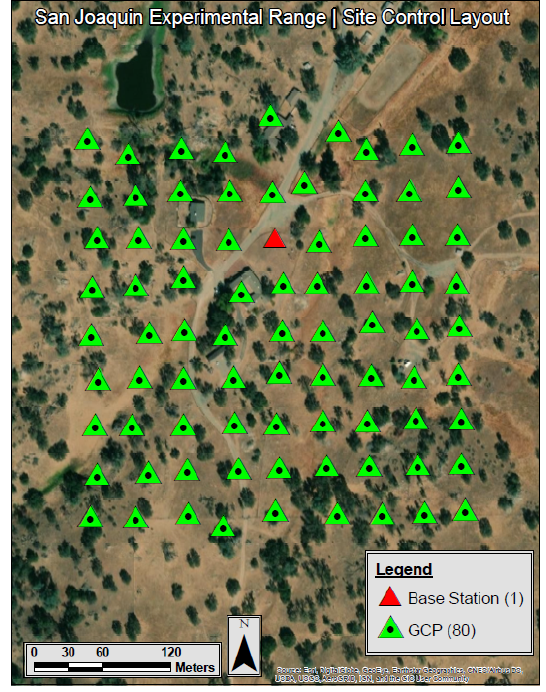
Fig. 1. Control points established in the project site (image is pre- pared using ESRI ArcMap).